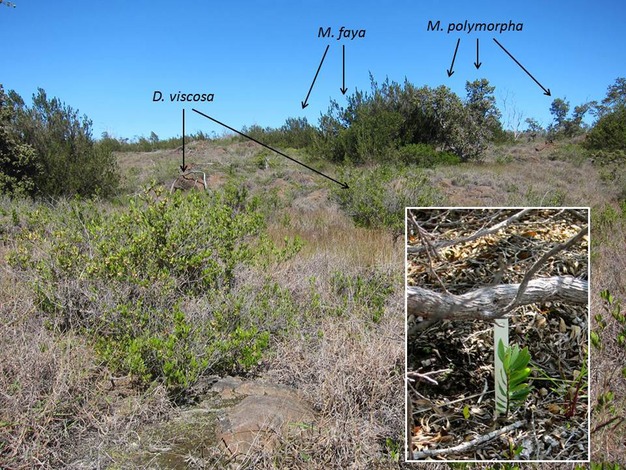
Photograph of degraded Metrosideros polymorpha woodland showing native Dodonaea viscosa shrubs and invasive Melinis minutiflora grass matrix in the foreground, and M. polymorpha (new foliage has light green tips) and invasive Morella faya (dark green foliage only) in the background. Inset shows an outplanted Wikstroemia phillyreifolia seedling approximately 8 cm tall under a D. viscosa nurse shrub after 2 years. Main photograph: S. Yelenik, inset photograph: C. D'Antonio.